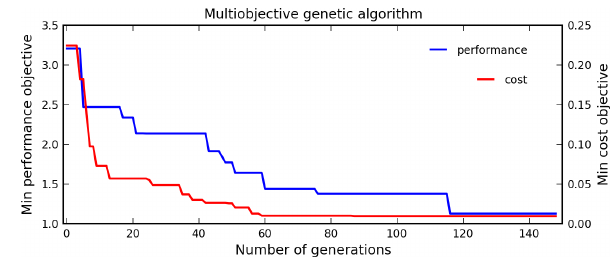
Figure 8. The figure displays the minimum value of the perfor- mance objective (blue line) and cost objective (red line) for each generation during the evolution of a population of network designs using